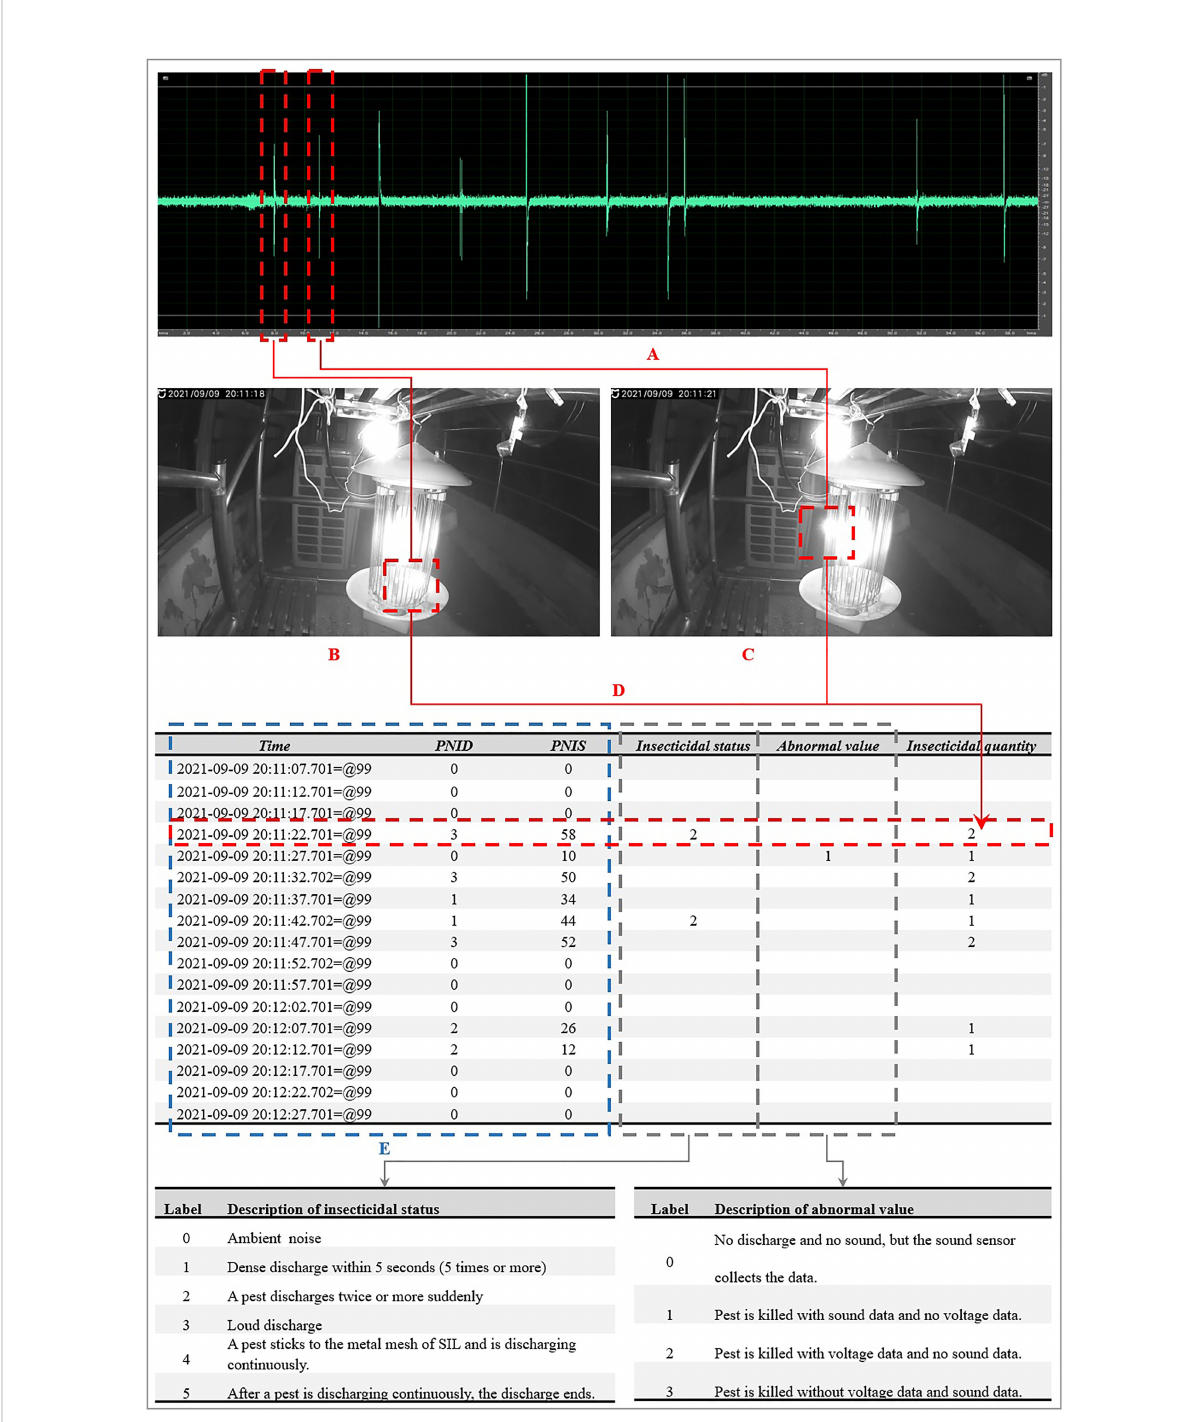
FIGURE 2 Sound wave was extracted from the video data (9/9/2021 20:11:10 - 9/9/2021 20:12:10) (A) , and two screen shots (B, C) were captured, indicating that two insects were killed by discharge (D) . Then the insecticidal quantity was labeled as “ 2 ” in the dataset, in which the time, PNID , and PNIS were the original data acquired from the testbed (E)